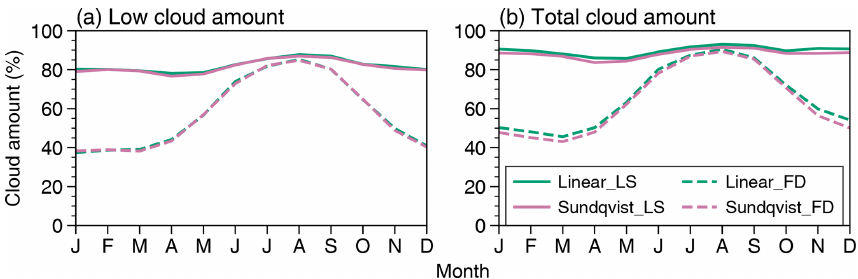
Figure 8. The seasonal cycle of (a) low and (b) total cloud amount (%) over the Arctic region (60–90 ◦ N) from the LS (solid lines) and FD (dashed lines) simulations, where the freeze-dry adjustment method is applied in the FD simulations. The green and pink colors denote the experiments performed with the linear and Sundqvist cloud schemes,